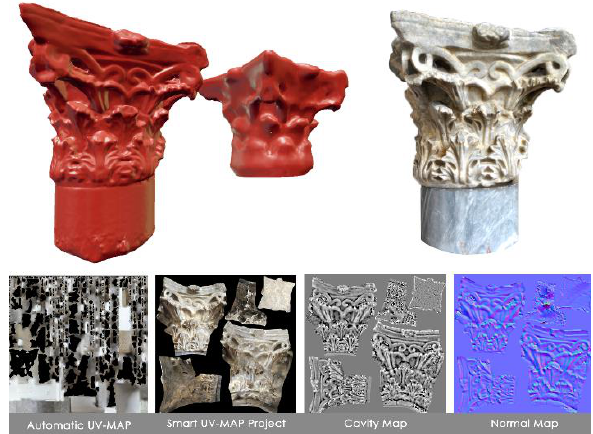
Figure 3. The Retopology phase on an architectural element and the Baking one by procedural 2D maps